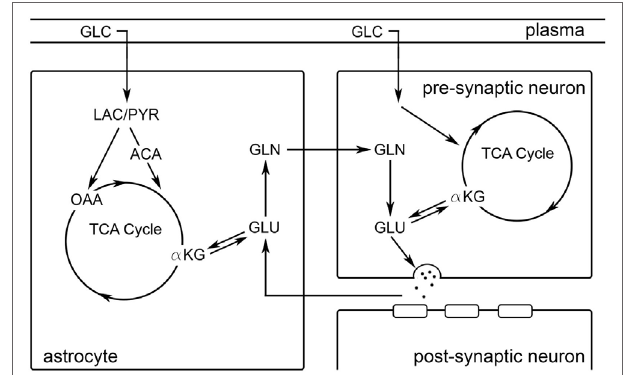
FigUre 1 | A schematic representation of the glutamatergic tripartite synapse is depicted. Black arrows illustrate relationships between molecular species. ACA, acetyl-CoA; α KG, α -ketoglutarate; GLC, glucose; GLN, glutamine; GLU, glutamate; LAC, lactate; OAA, oxaloacetate; PYR,